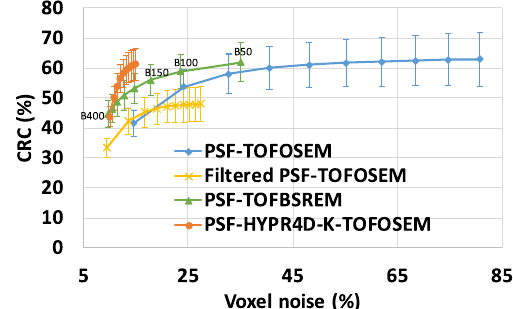
Fig. 2 Contrast recovery coefficient versus voxel noise for the 10 mm sphere obtained from various reconstruction methods. Each point represents an OSEM iteration except for PSF‑TOFBSREM where each point represents a beta value ranging from 50 to 400. The beta value increases from right to left with an increment of 50 (see labels for guidance) while the number of OSEM iteration increases from left to right